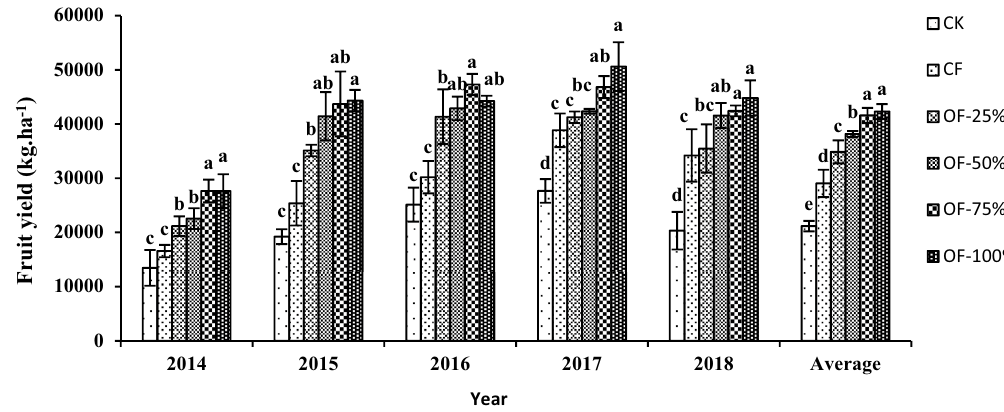
Figure 3. Fruit yield of watermelon over 5 years under different inorganic and organic fertilization treatments in a gravel mulch. Bars within the same year followed by the same letter are not significantly different at P = 0.05. CK, no N fertilizer; CF, N fertilizer without organic fertilizer; OF-25%, OF-50%, OF-75%, and OF-100%, 25%, 50%, 75%, and 100% organic